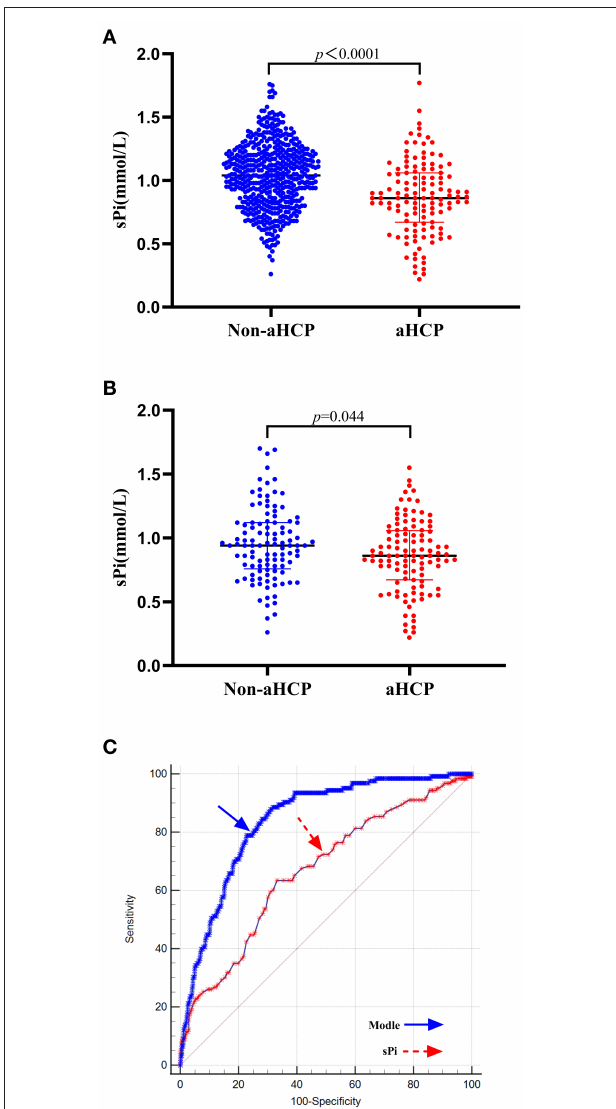
FIGURE 2 | Association of sPi levels with aHCP. (A) sPi levels in patients with non-aHCP ( n = 512) and aHCP ( n = 123). (B) sPi levels in patients with non-aHCP ( n = 108) and aHCP ( n = 108) after PSM. (C) ROC curve analysis for predicting aHCP. The optimal cutoff value for sPi level as a predictor for aHCP in aSAH patients was determined to be 0.93 mmol/L (AUC was 0.667, the sensitivity was 63.4%, and the specificity was specificity 66.8%). The AUC of the logistic regression model based on these predictors (sPi, Hunt-Hess grade, and mFisher grade) was 0.840 with a sensitivity of 88.6% and specificity of 68.4% for aHCP, which is a stronger aHCP predictor than a single sPi level. Median with IQR was shown for all scatter plots in (A,B) . Mann-Whitney tests were performed to compare differences between groups. aSAH, aneurysmal subarachnoid hemorrhage; aHCP, acute hydrocephalus; AUC, area under the curve; IQR, interquartile range; PSM, Propensity-score matching; ROC, Receiver operating curve; sPi, serum phosphate ion.